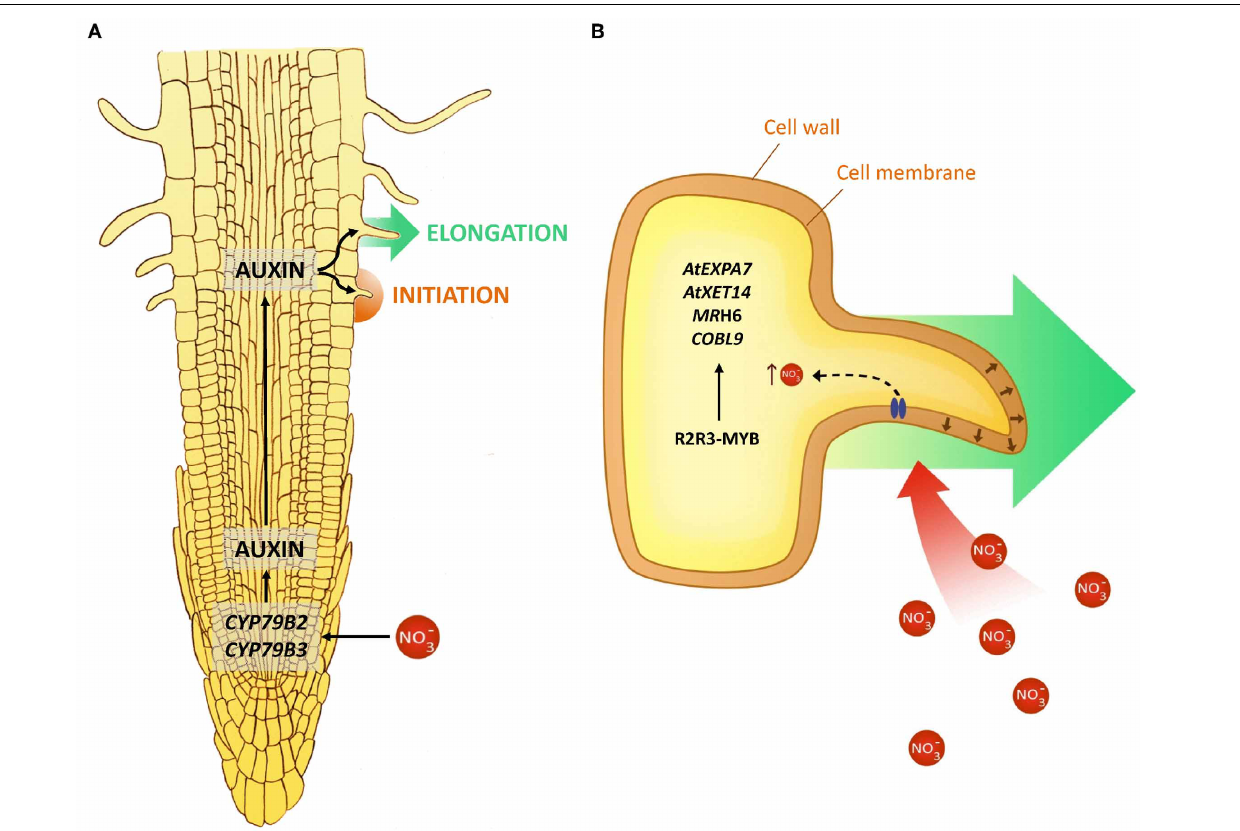
FIGURE 4 | Proposed model of how nitrate modulates root hair development in Arabidopsis . (A) Nitrate treatments induce auxin biosynthesis and this phytohormone promotes root hair initiation and elongation. (B) Schematic detail of a root hair and genes involved in their growth mediated by nitrate.